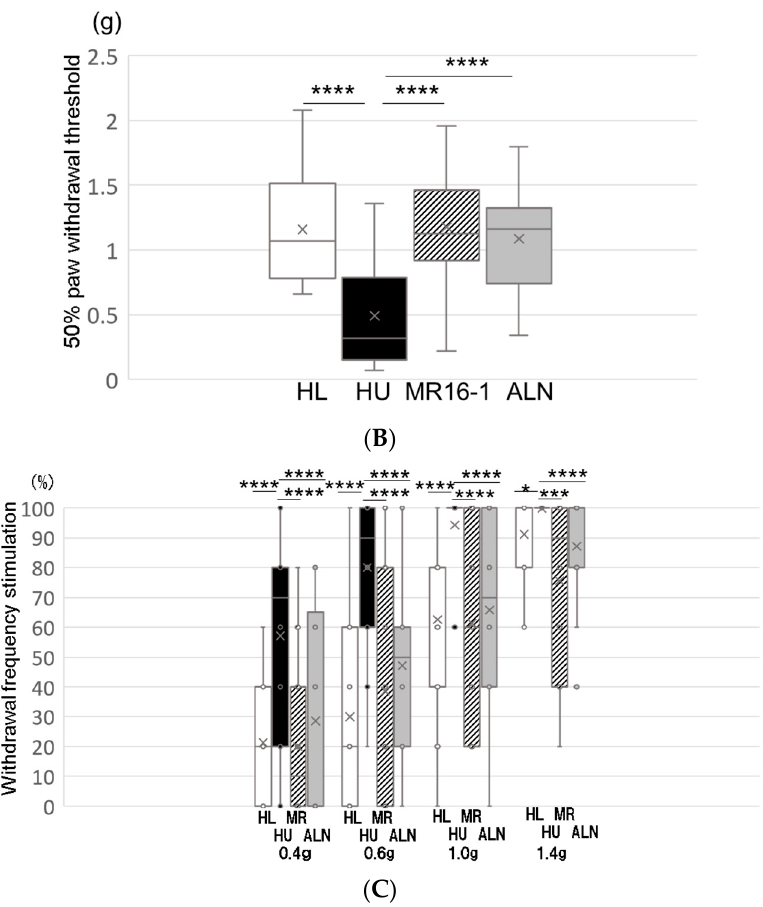
Figure 1. Effect of pain-related behavior by anti-IL-6 antibody and alendronate (ALN) administration in hindlimb-unloaded (HU) mice: ( A ) Paw withdrawal threshold (g). ( B ) 50% paw withdrawal threshold by the up-down method (g). ( C ) Withdrawal frequency stimulation (%). Top, bottom, and middle lines of the graph correspond to the 75th percentile, 25th percentile, and median, respectively. Cross represents mean. Each circle represents an outlier ( n = 8 in each group). * p < 0.05, *** p < 0.005, and **** p < 0.001.